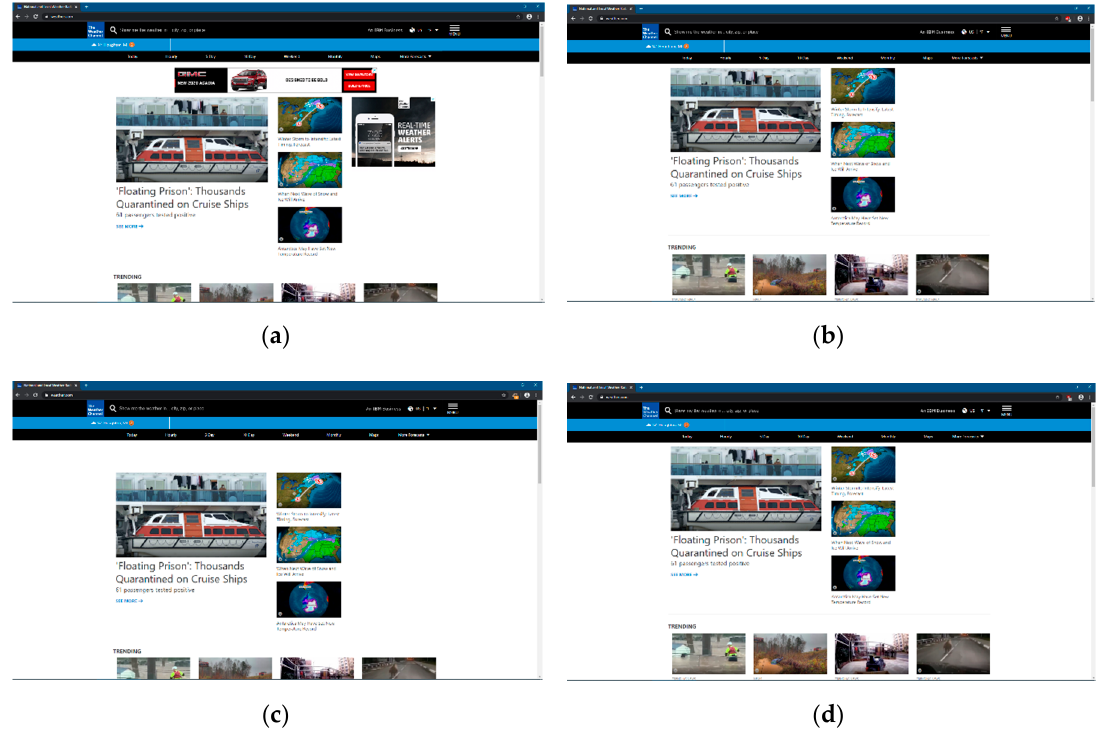
Figure 1. The impact of open source ad blockers on the Weather Channel website: ( a ) no ad block, ( b ) AdBlock+, ( c ) Privacy Badger, and ( d ) uBlock Origin.